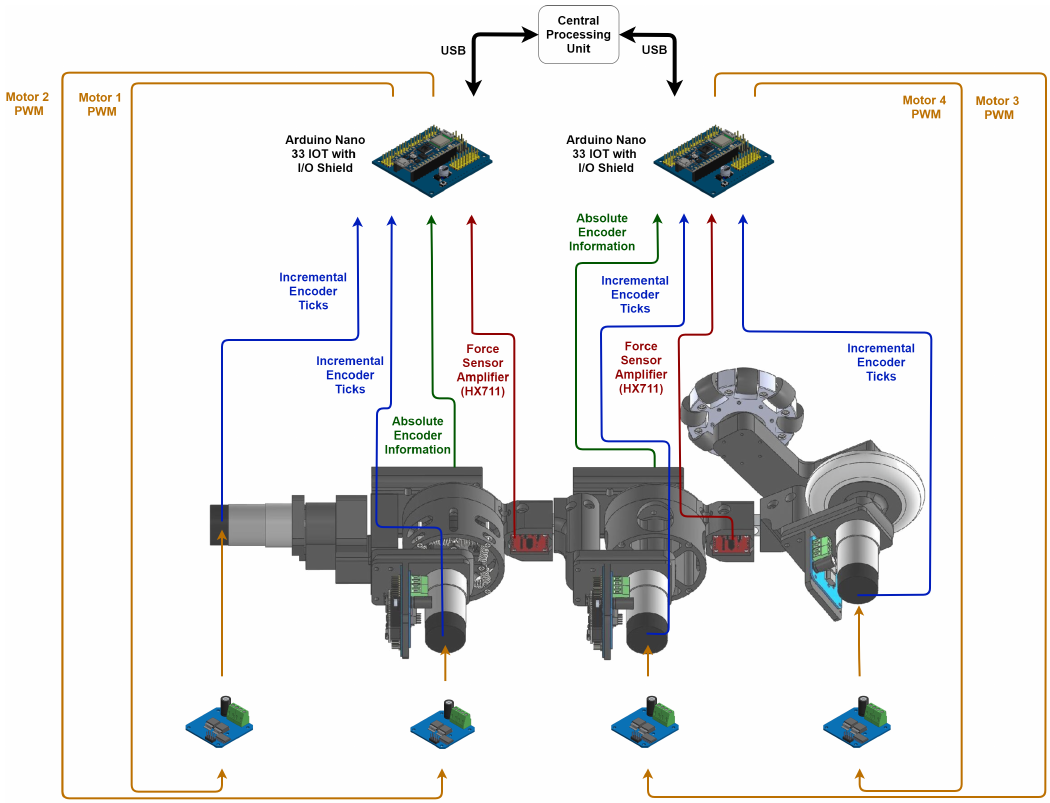
Figure 3. Leg connections